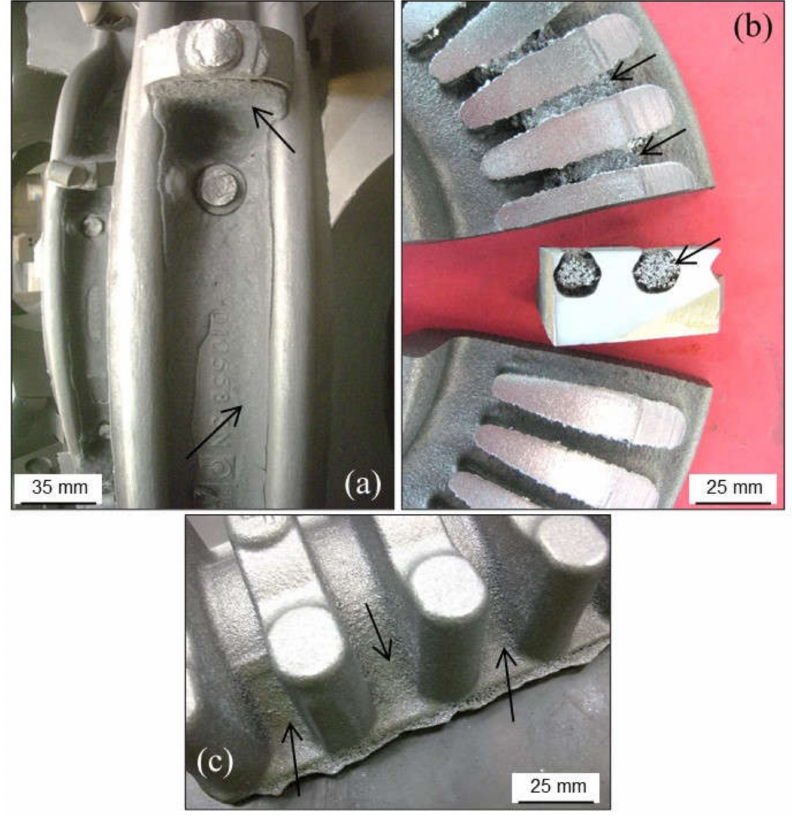
Figure 16. Metal penetrations found in ( a ) a ductile iron casting inner zone shaped with a chemically bonded mold with low compaction of sand; ( b ) a grey iron brake disc with compaction problems in some areas of the core; ( c ) overheated areas of a ductile iron casting produced with a green sand